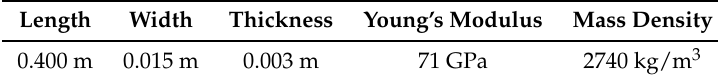
Table 2. Mechanical properties of the aluminium